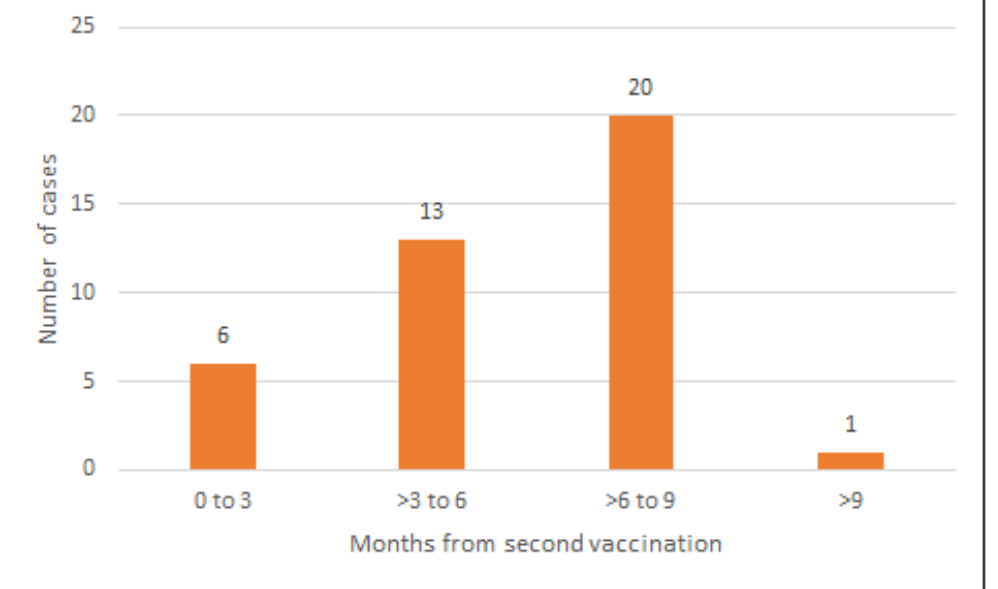
Figure 3. Time in months between the second dose of COVID-19 vaccination and the forty COVID-19 break-through infections before the Omicron proxy period (21 December 2021).